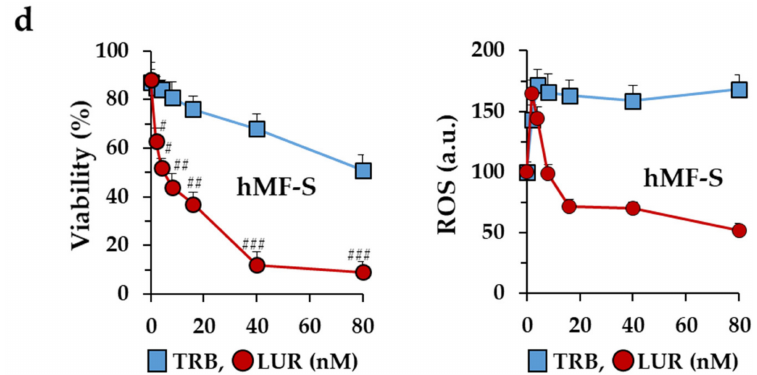
Figure 1. E ff ect of trabectedin (TRB) and lurbinectedin (LUR) on the viability of human macrophages. ( a ) Dose-dependent e ff ect on cell viability and reactive oxygen species (ROS) production of TRB and LUR on THP-1 macrophages after 24 h of incubation; ( b ) distribution of TRB- and LUR-sensitive (hMF-S) and -resistant (hMF-R) human macrophages (hMFs) di ff erentiated from monocytes from healthy donors; ( c ) e ff ect on cell viability and ROS production of hMFs after 24 h of treatment with 100 nM TRB and 50 nM LUR; ( d ) dose-dependent e ff ect of TRB and LUR on cell viability and ROS production of hMF-S. Results show the means + S.E.M. of 4 independent preparations of THP-1 cells, or the means + S.E.M. of cells from 8 (panels a,d) and 12 (panel c) di ff erent donors. * p < 0.05; *** p < 0.005 vs. the vehicle (Veh.) condition; # p < 0.05; ## p < 0.01; ### p < 0.005 vs. the corresponding condition with TRB. a.u., arbitrary